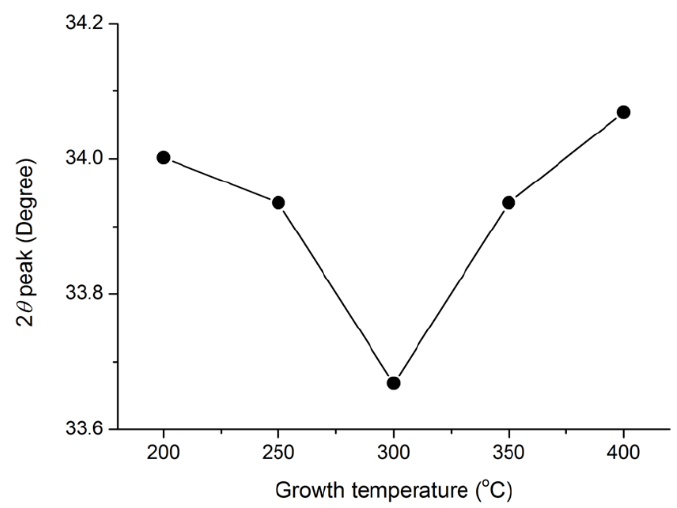
Figure 3. 2 θ angle of (002) diffraction peak of WZO films as a function of different growth temperatures (from 200 to 400 °C).